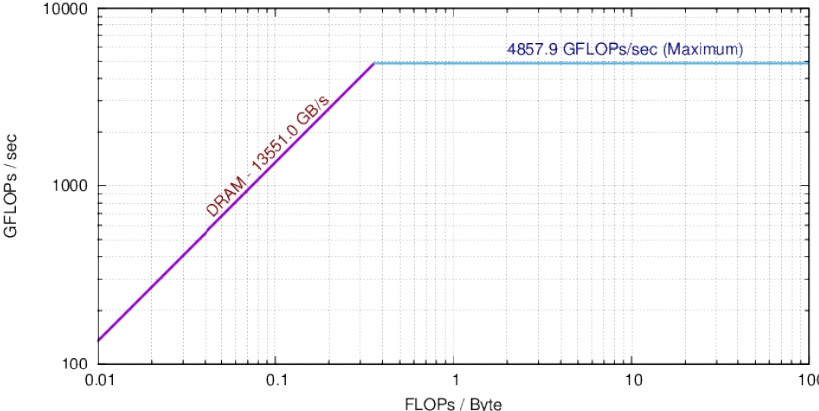
Figure 6. lERT Roofline model of SummitDev GPUs, to show attainable peak